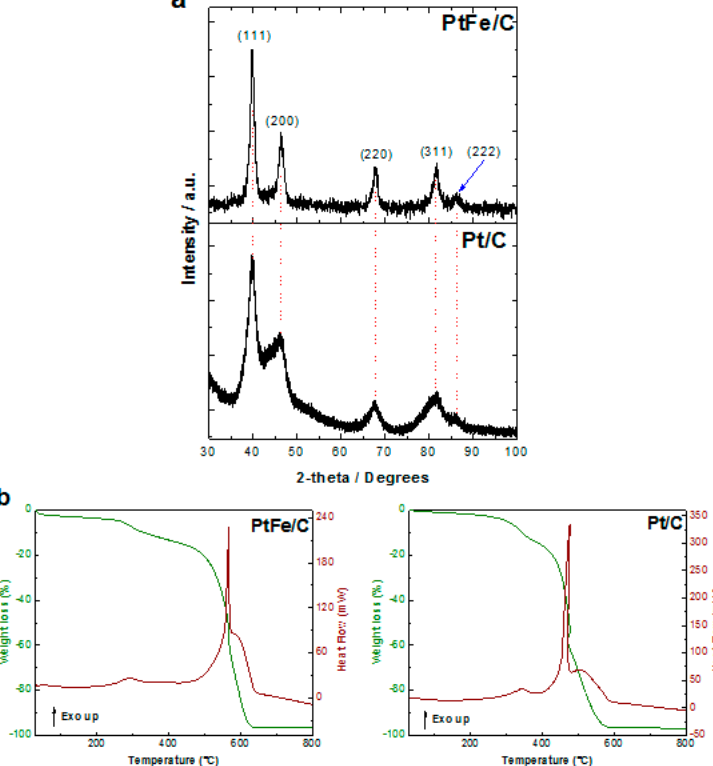
Figure 1. ( a ) X-ray diffraction patterns of Pt/C and PtFe/C nanocatalysts; ( b ) Thermogravimetric analyses for Pt/C and PtFe/C.